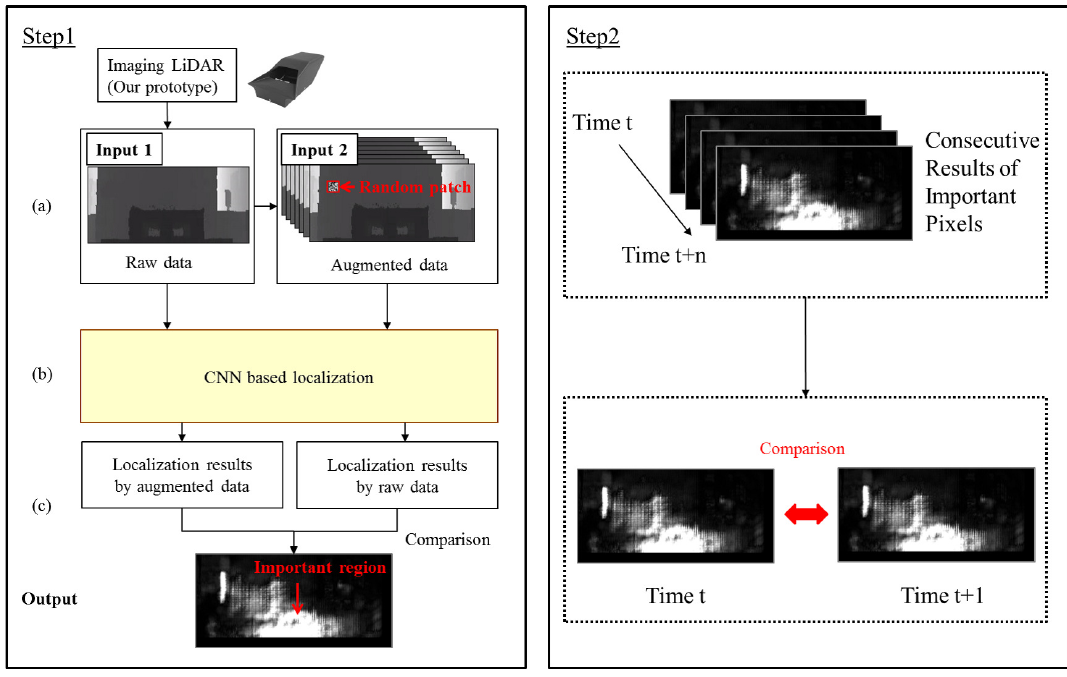
Figure 5. Overview of the